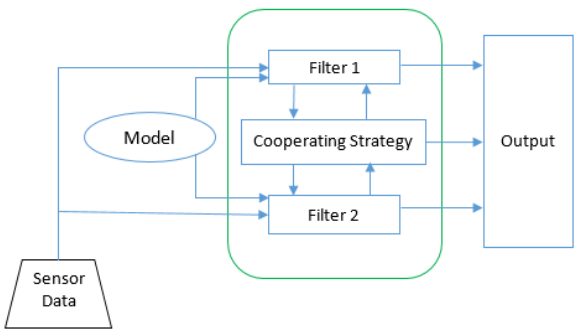
Figure 13. Graphical depiction of the tracking module with two motion models.